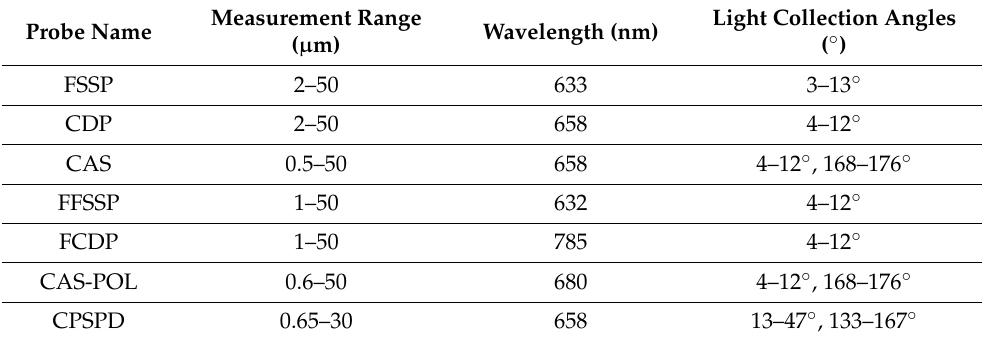
Table 1. Specification of forward scattering probes (i.e., on-axis scattering